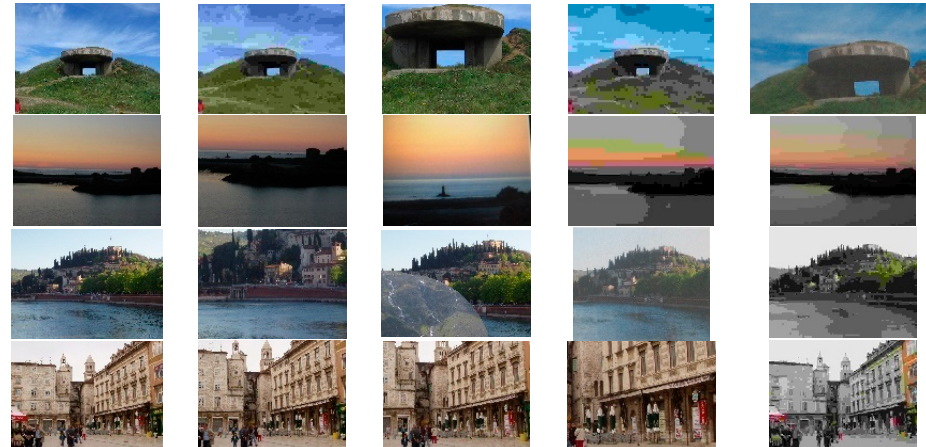
Figure 9. The examples of our detection results (four queries and the corresponding four detected images) on the Copydays dataset. All of these detected images are the image copies.